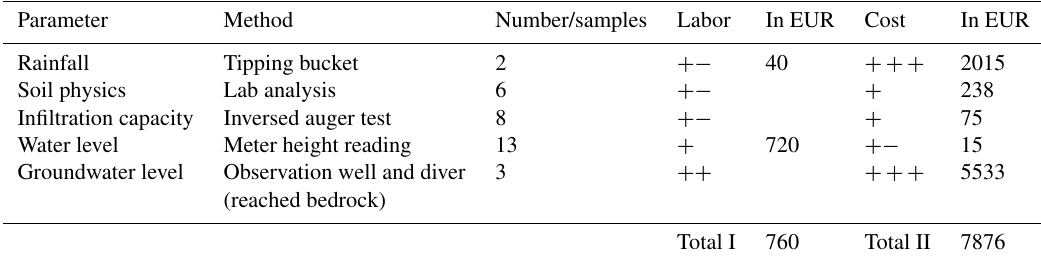
Table A2. Vietnam Case, scenario 2: to recheck the signal of recharge. Parameter Method Number/samples Labor In EUR Cost In EUR Rainfall Tipping bucket 2